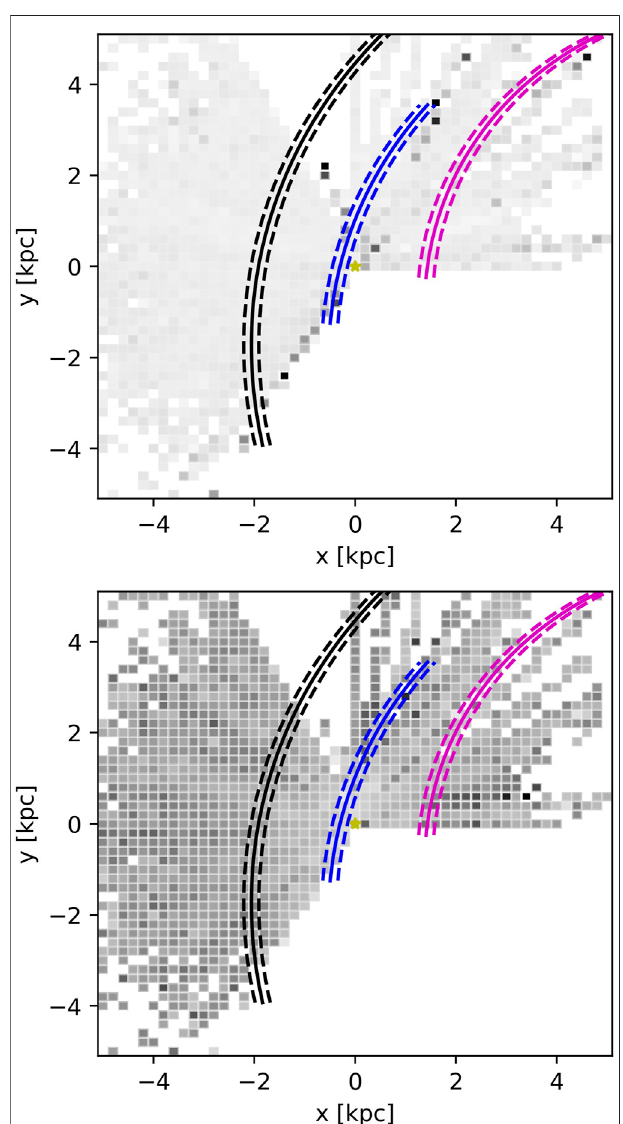
FIGURE11| ThemapsoftheDIBat1.5273 μ m,basedonthedatafrom Elyajouri and Lallement (2019). The upper plot displays the distribution of the ratiosEW / A V ,thelowerplotshowsthedistributionofEWs.Thedarkerthecell, the higher the value. The coordinates are centered at the position of the Sun (not the Galacto-centric coordinates). The nearby spiral arms from Reid et al. (2014) are displayed with different colours (black — Perseus Arm, blue — Local Arm, magenta — Sagittarius Arm); the corresponding dotted lines emphasize their